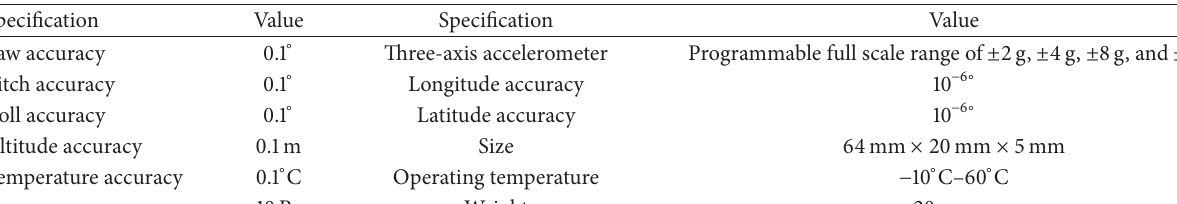
Table 2: COTS AHRS plus GPS specifications.